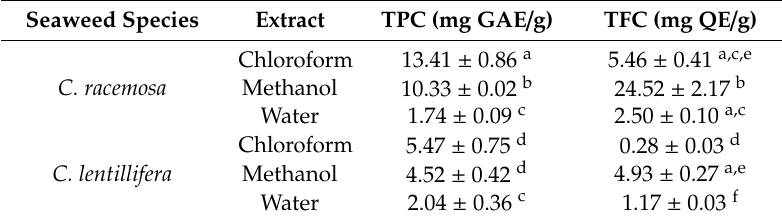
Table 2. The total phenolic content (TPC) and total flavonoid content (TFC) in C. racemosa and C. lentillifera crude